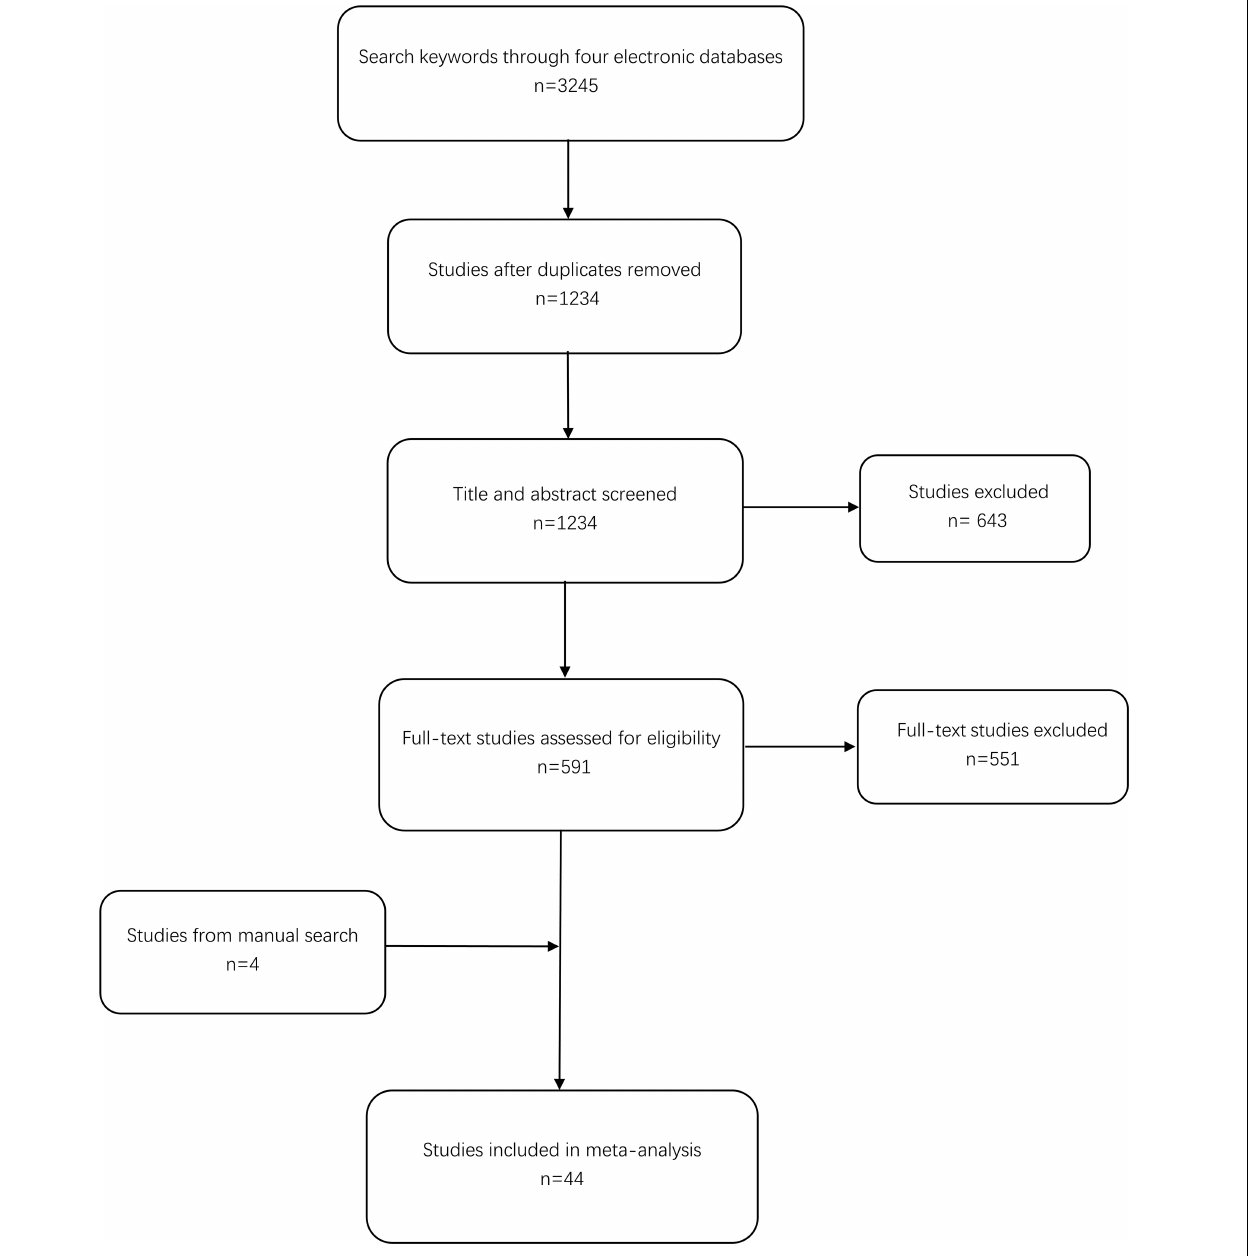
FIGURE 1 | Selection process for studies included in the